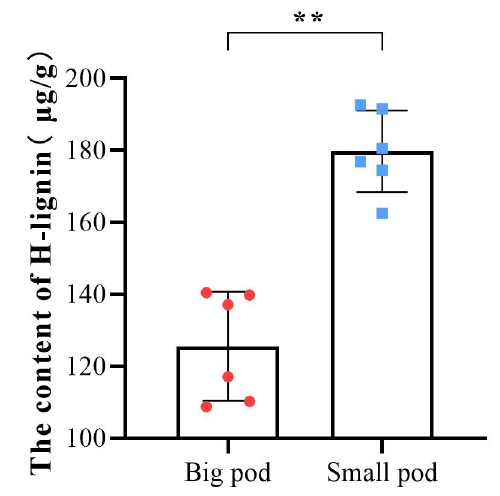
Figure 8. Determination of the H-lignin content in pods of 12 peanut varieties at 30 DAP. The color red corresponds to peanut varieties with larger pod sizes, and blue corresponds to peanut varieties with smaller pod sizes. Each point represents one variety. ** p < 0.01.